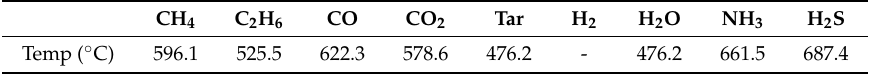
Table 5. The temperature corresponding to peak release rate of volatile components.